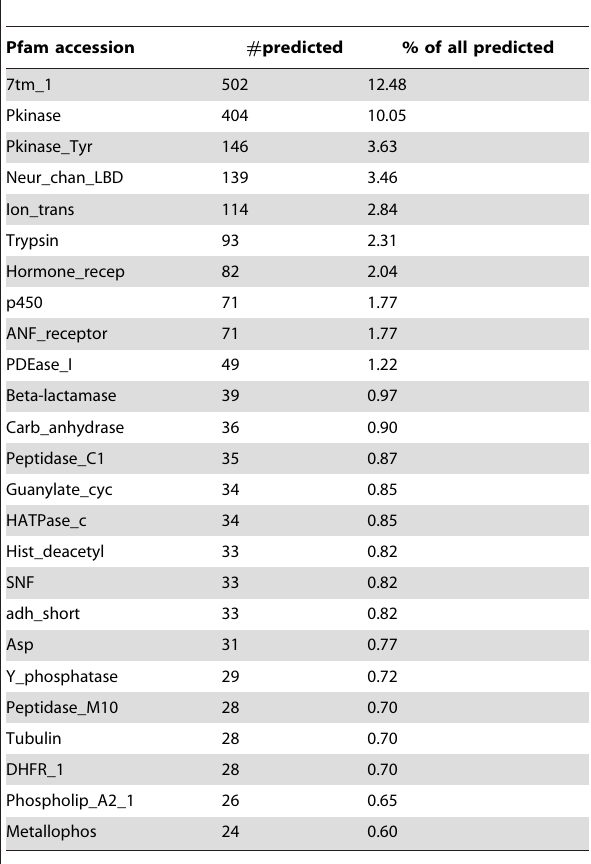
Table 2. The most frequent ligand binding domains in the ChEMBL target